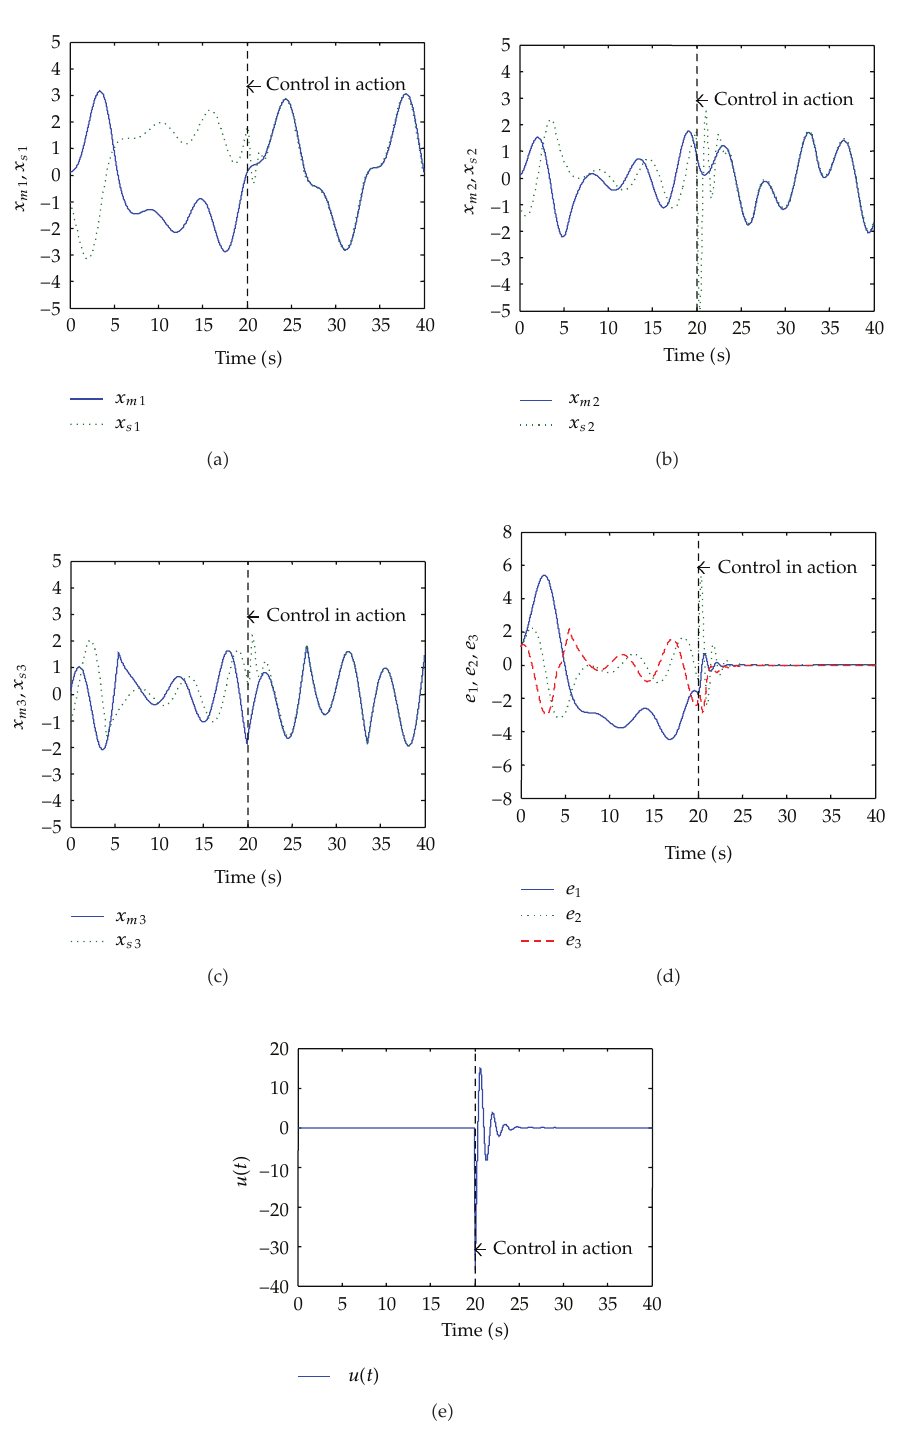
Figure 4: Time responses using the EP-based PID controller. (cid:2) a (cid:3) x m 1 versus x s 1 . (cid:2) b (cid:3) x m 2 versus x s 2 . (cid:2) c (cid:3) x m 3 versus x s 3 . (cid:2) d (cid:3) The error states e 1 , e 2 , e 3 . (cid:2) e (cid:3) The control input. (cid:2) The control u (cid:2) t (cid:3) is activated at t (cid:7) 20sec. (cid:3)